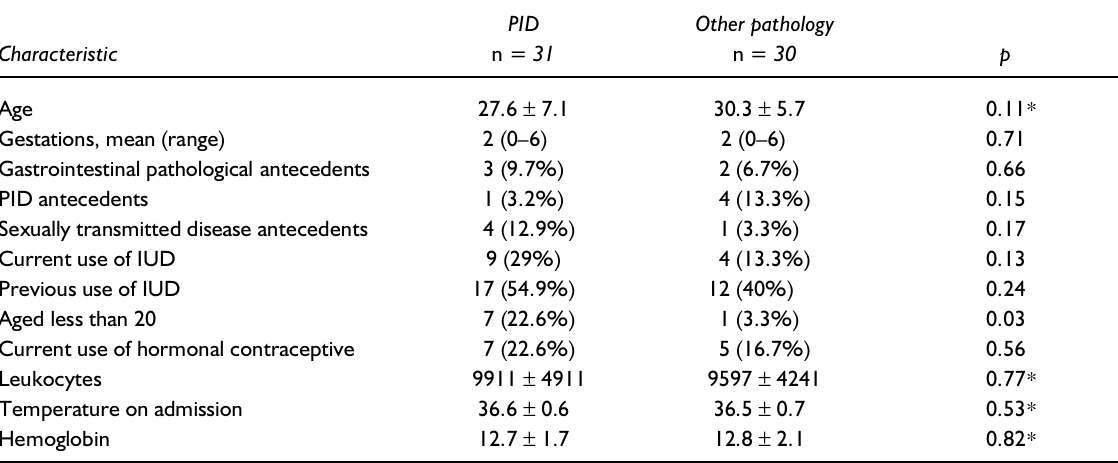
Table 1 Base characteristics for 61 patients having non-specific acute lower abdominal pain